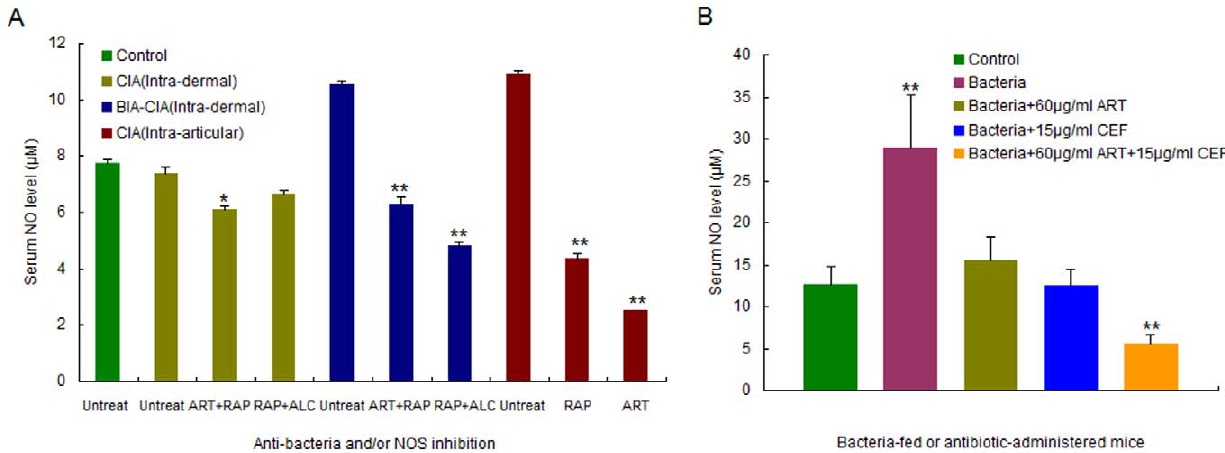
Figure 7. Abrogation of NO production after anti-bacteria and/or NOS inhibition in BIA, CIA and BIA-CIA mice. A. Serum NO levels in drug-administered BIA, CIA and BIA-CIA mice ( n =3). The serum NO level was determined after anti-bacteria and/or NOS inhibition of modeling mice by 60 m g/ml artesunate, 50 m g/ml rapamycin, 15% alcohol or a combination of drugs; B. Serum NO levels in bacteria-fed or antibiotic-administered mice ( n =10). The serum NO level was determined after live bacterial feeding for 7 d and injecting artesunate, cefotaxime, or the combination of artesunate with cefotaxime for 3 d (twice a day). ART: artesunate; CEF: cefotaxime; RAP: rapamycin; ALC: alcohol. The singular asterisk (*) represents statistically significant difference from the control ( P , 0.05); and double asterisks (**) indicate statistically very significant difference from the control ( P , 0.01). doi:10.1371/journal.pone.0034494.g007 PLoS ONE |